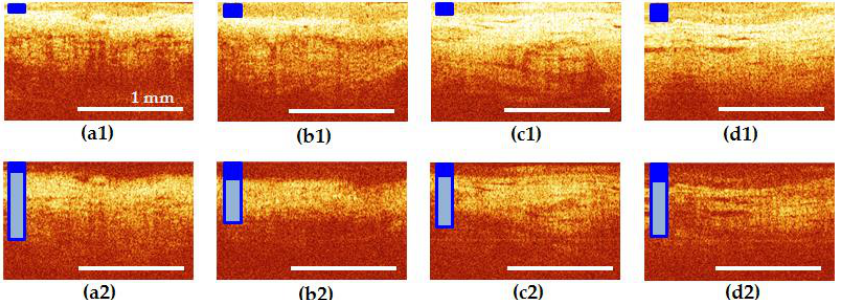
Figure 4. CP OCT images of the bladder neck ( a ) and three segments of normal urethra ( b – d ): ( b ) proximal; ( c ) middle; and ( d ) distal. The first row shows co-polarization images, the second row shows corresponding cross-polarization images. The first (epithelial) layer and its thickness are marked in all images with a dark blue rectangle. The second layer (connective tissue of lamina propria) in ( a2 – d2 ) is indicated by a vertical rectangle in light blue color: its height shows the average height of the layer and the blue color inside the frame indicates its normal condition.